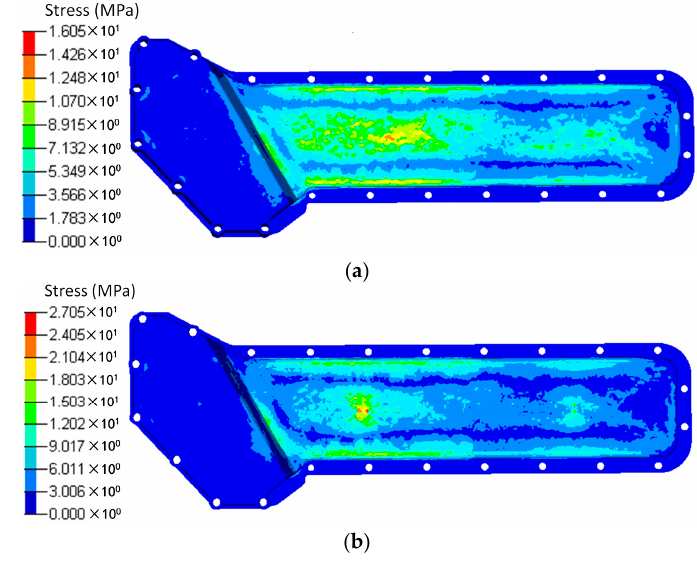
Figure 14. Stress distributions of ( a ) the isotropic and ( b ) the orthotropic oil cooler covers under distributed pressure.